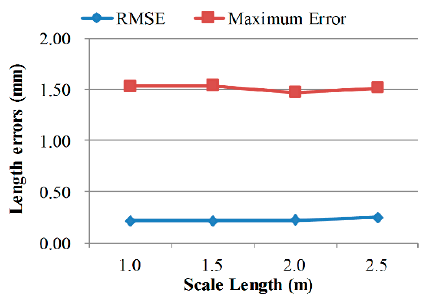
Figure 9. Calibration performances when using different calibrating bar lengths.